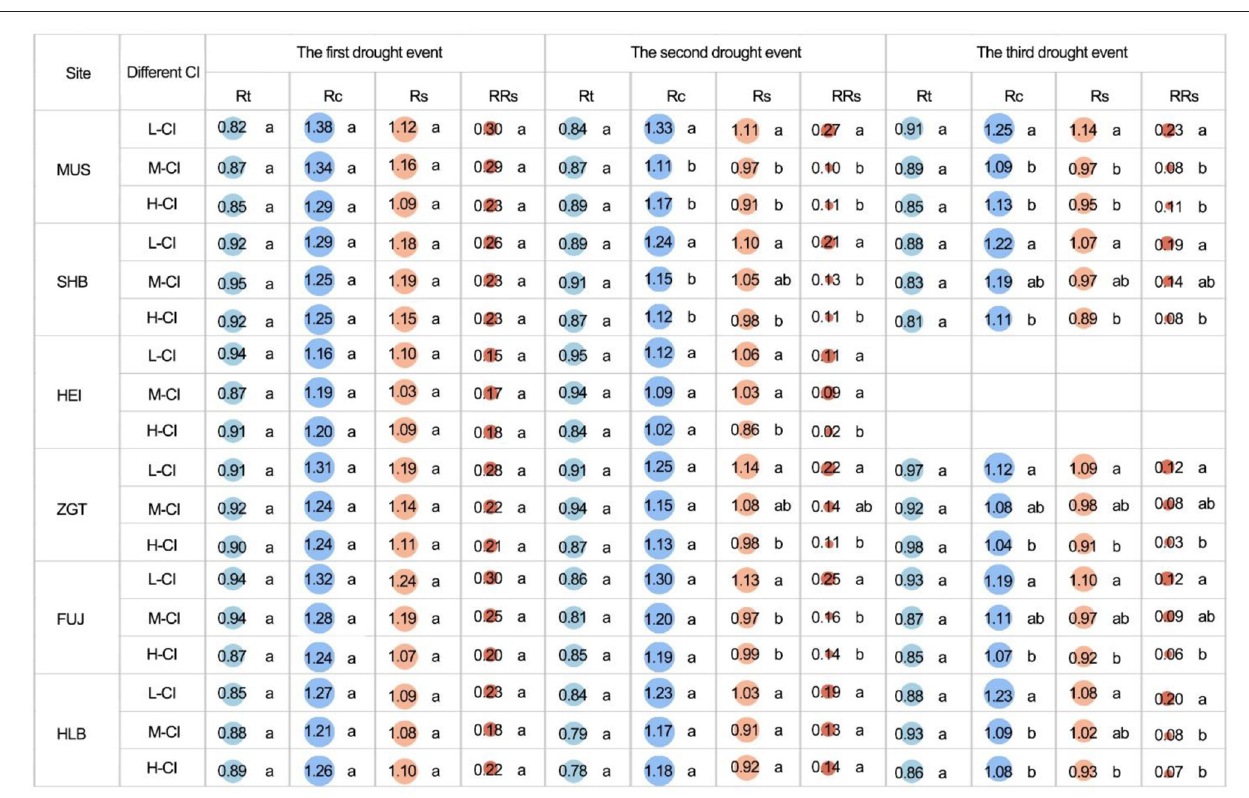
FIGURE 8 | Resistance (Rt), recovery (Rc), resilience (Rs), and relative resilience (RRs) among the all competition index (CI) groups of Mongolian pine trees. Lower-case letters indicate significant differences at p <